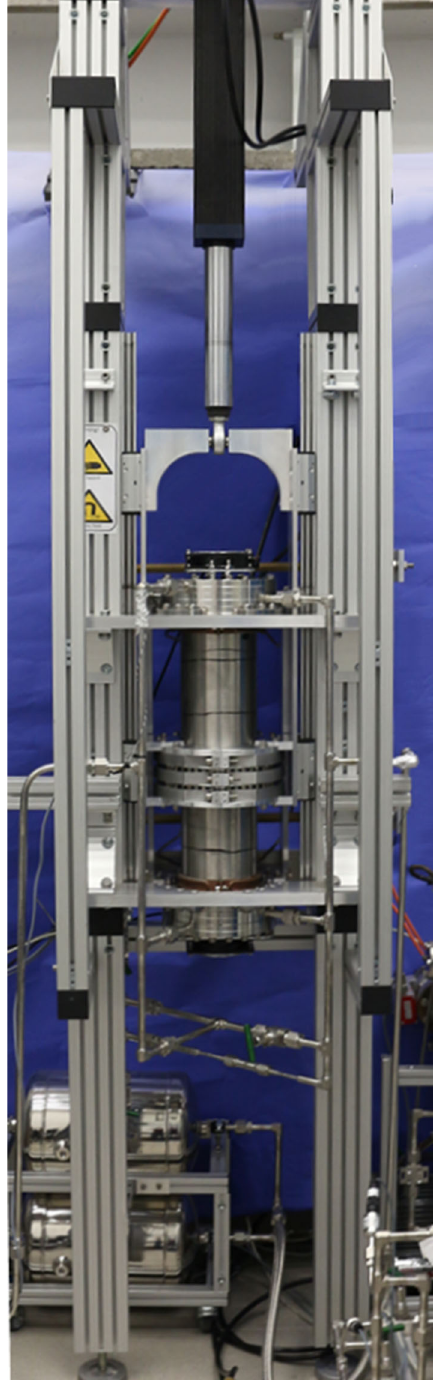
Fig. 11 Fully assembled pump at Muenster pump test station